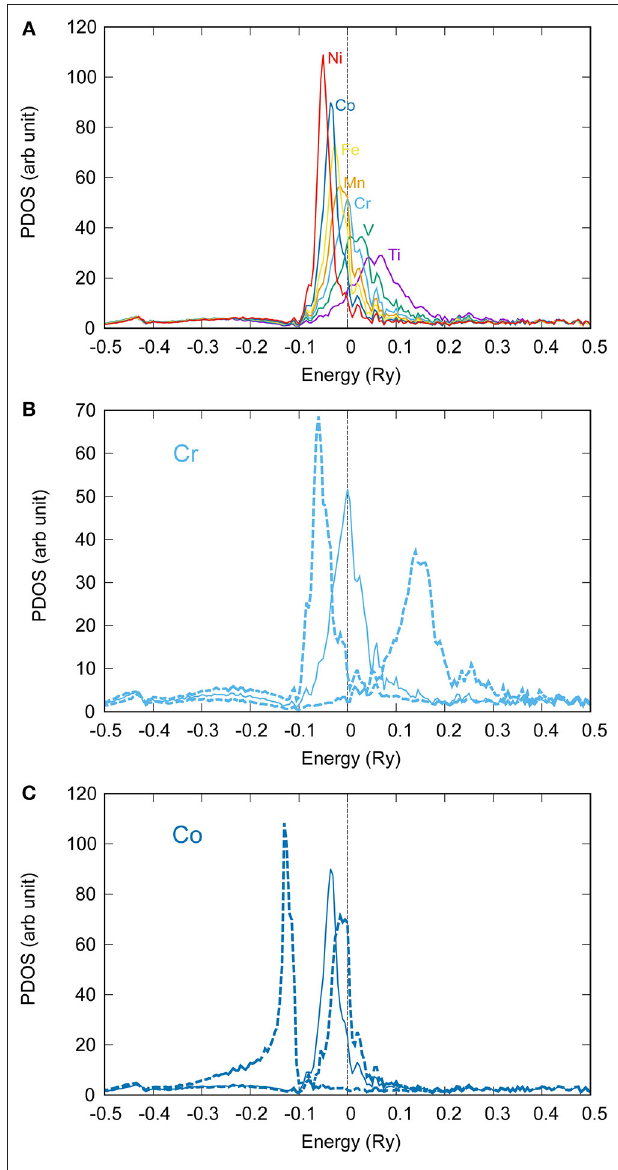
FIGURE 2 | Partial density of states (PDOS) of impurity elements in fcc Au. (A) PDOS of Ti (purple), V (green), Cr (cyan), Mn (orange), Fe (yellow), Co (blue), and Ni (red) without local magnetic moment. (B) PDOS of Cr with (broken lines) and without (solid line) local magnetic moment. (C) PDOS of Co with (broken line) and without (solid line) local magnetic